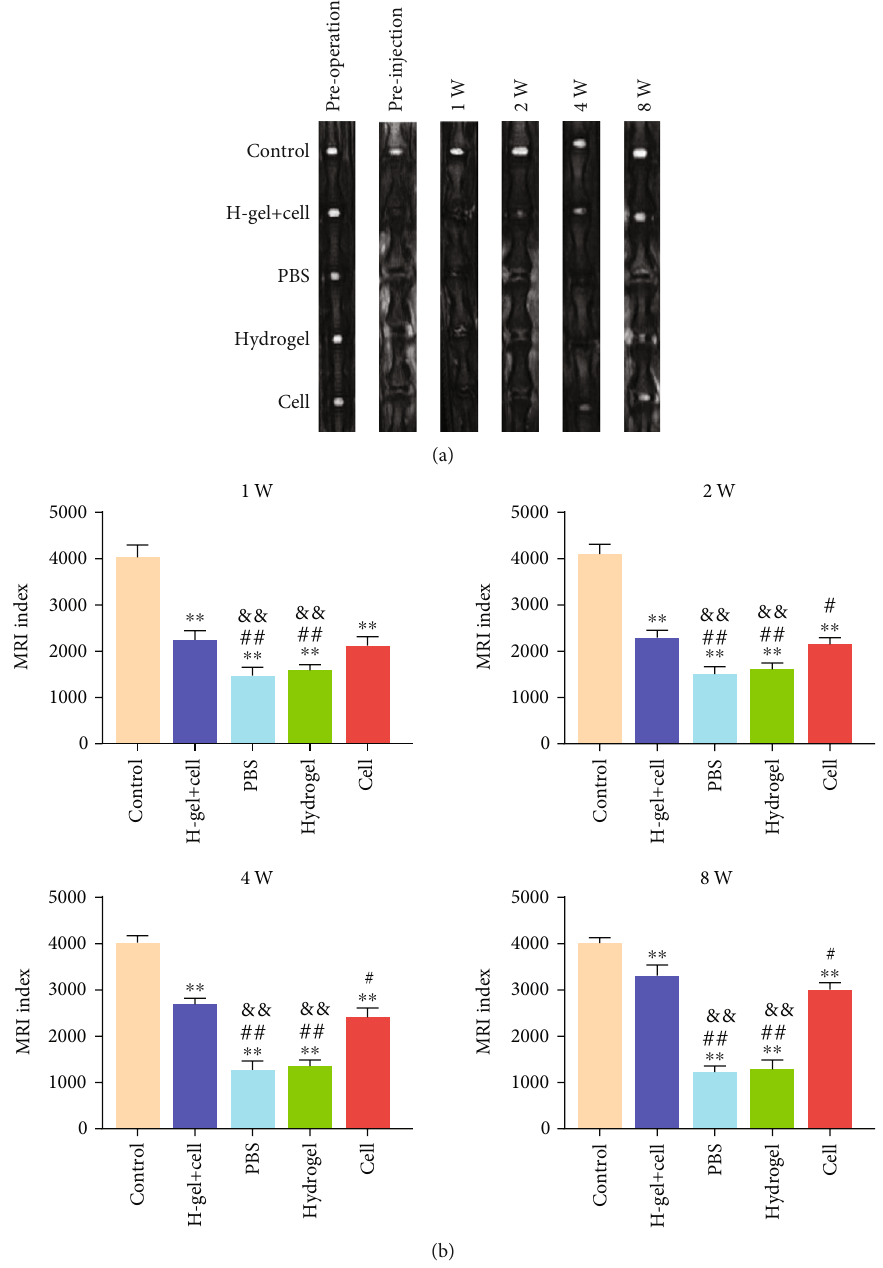
Figure 7: MRI images and MRI index of di ff erent groups. (a) Typical T2-weighted MRI images of di ff erent groups preoperation, preinjection, and 1, 2, 4, and 8 weeks after injection. (b) The MRI index was applied to quantitatively evaluate the rehydration and regeneration of degenerative disc. The H-gel+cell group is the hydrogel+cell group. All data are expressed as the mean ± SD ; the error bars represent the standard deviation of measurements for 6 separate samples ( n = 6 ); ∗ p < 0 : 05 , ∗∗ p < 0 : 01 compared with control group; # p < 0 : 05 , ## p < 0 : 01 compared with hydrogel+cell group; & p < 0 : 05 , && p < 0 : 01 compared with cell